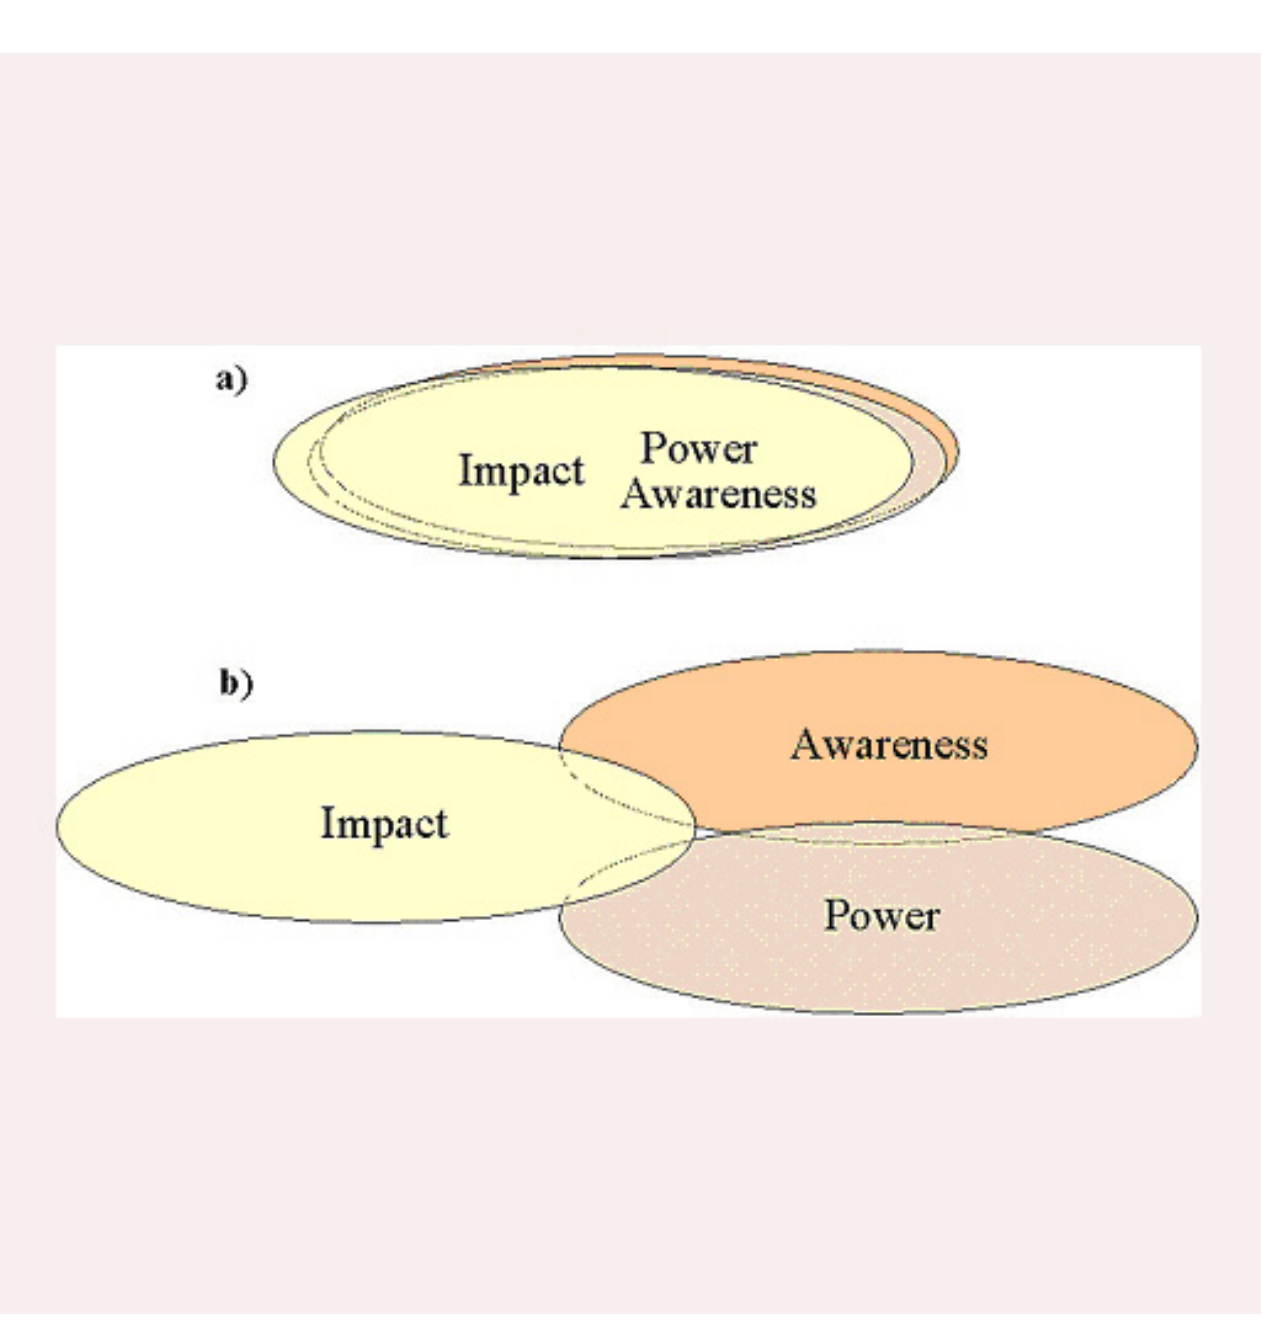
Fig. 2. (A) Impact, awareness, and power scopes are nearly congruent. (B) Impact, awareness, and power scopes are highly